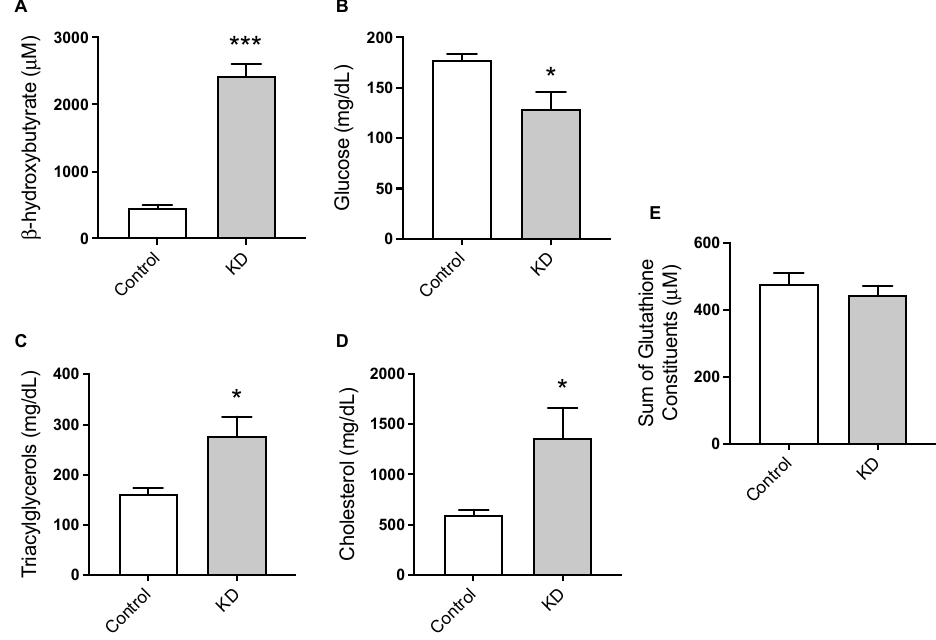
Figure 2. The effect of the experimental diets on the circulating levels of ( A ) ß-hydroxybutyrate, ( B ) glucose, ( C ) triacylglycerols, ( D ) total cholesterol, and ( E ) the sum of glutamate, glycine, and cysteine. Data shown are the mean ± SEM, n = 7–8/group. *, p < 0.05; ***, p < 0.001, KD versus control.